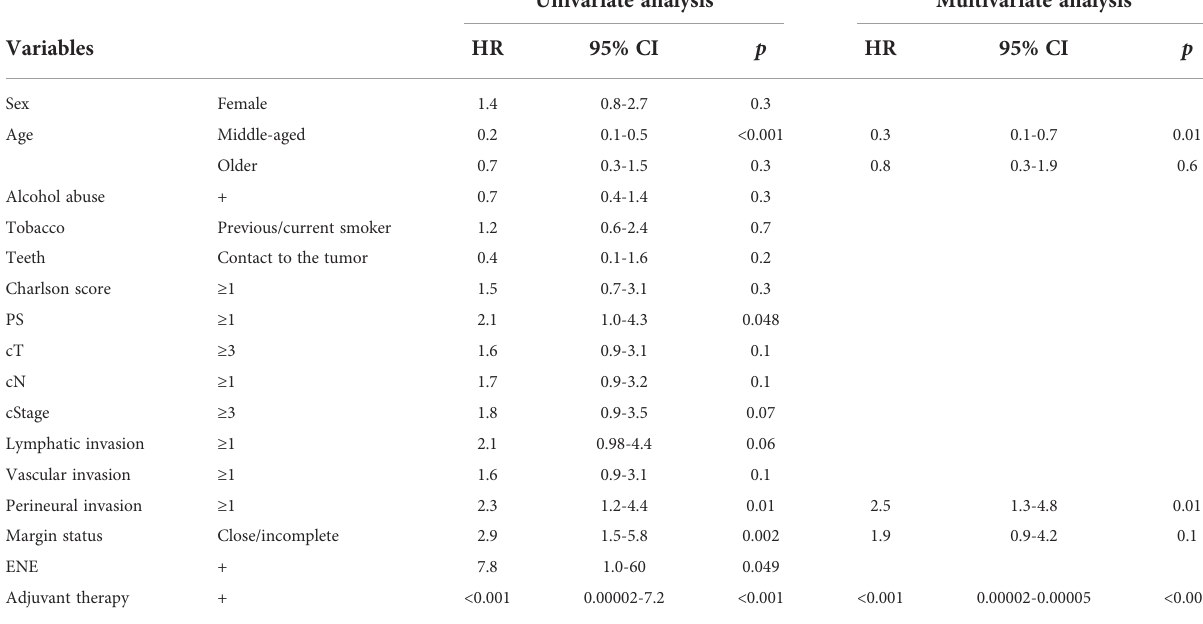
TABLE 4 Univariate and multivariate competing risk regression models for local